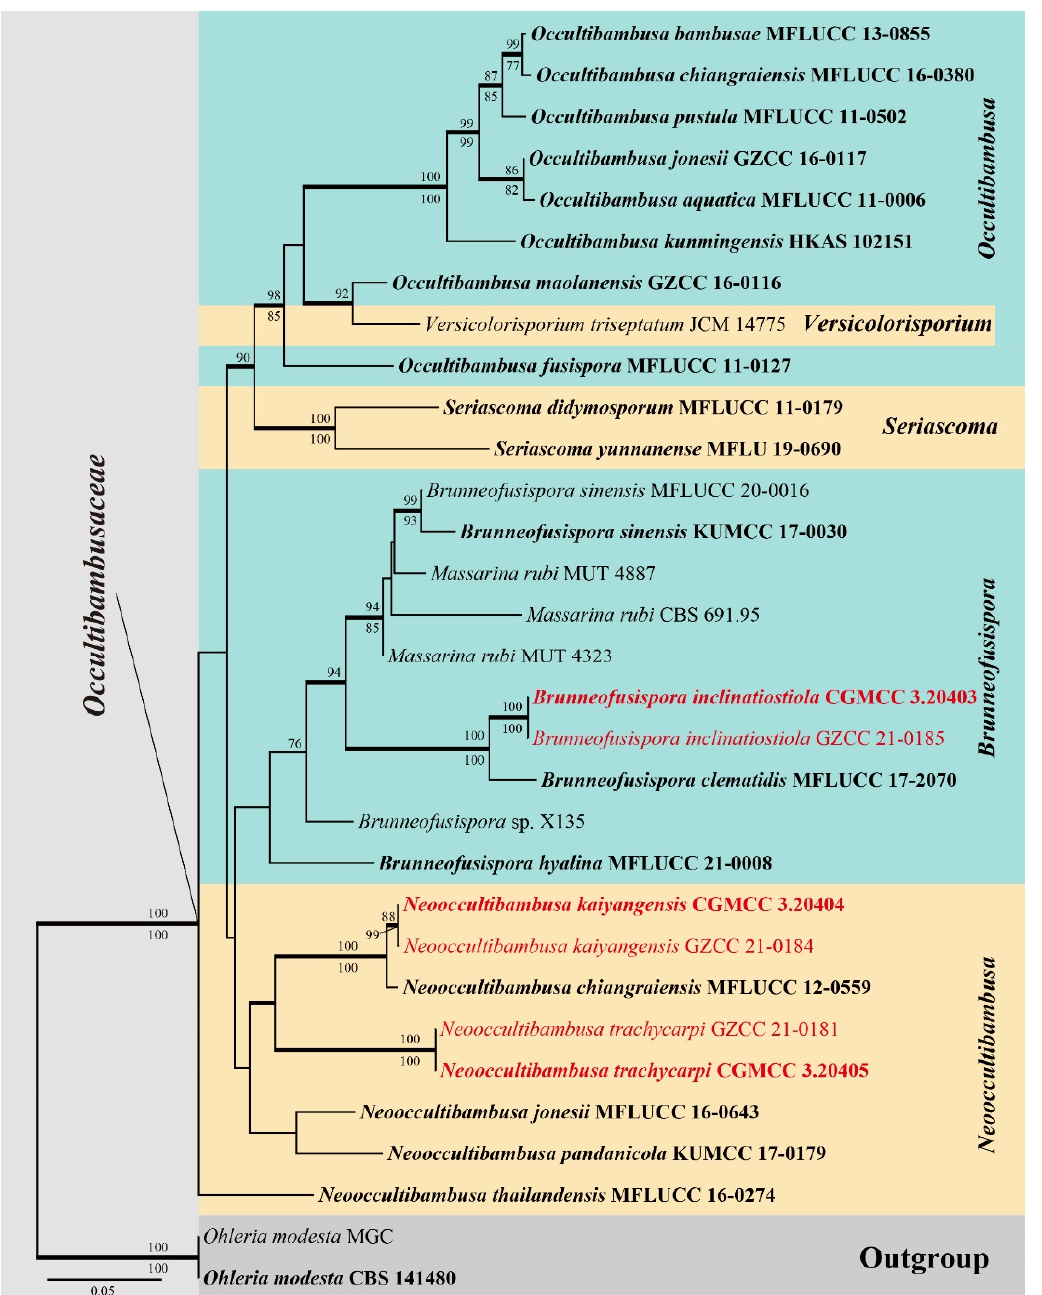
Figure 1. RAxML tree generated from combined SSU, ITS, LSU, RPB2 and TEF1 α sequence data. Bootstrap values for ML and MP equal to or greater than 75% are placed above and below the branches respectively. Branches with Bayesian posterior probabilities (PP) from MCMC analysis equal or greater than 0.95 are in bold. The tree is rooted with Ohleria modesta (CBS 141480) and O. modesta (MGC). The ex-type strains are indicated in bold and newly generated sequences are indicated in red.